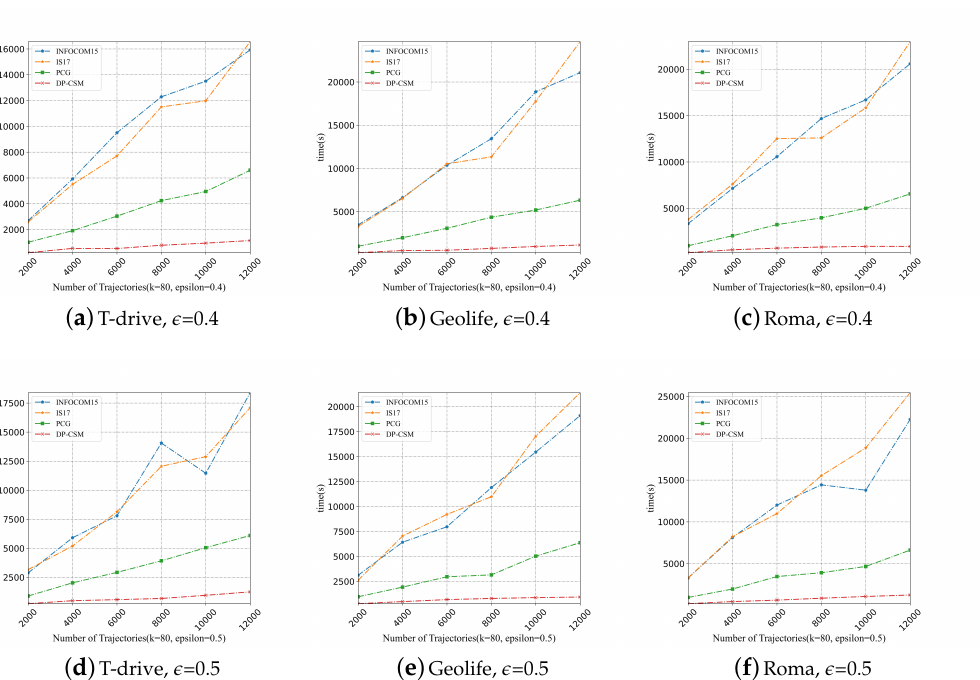
Figure 11. Impact of dataset size on the efficiency of the four methods. In these experiments, we fix k = 80, and choose two kinds of privacy budget, i.e., (cid:101) = 0.4, and (cid:101) = 0.5. For each privacy budget and dataset, we vary the size | D | from 2000 to 12000, and compare the running times of the four methods.